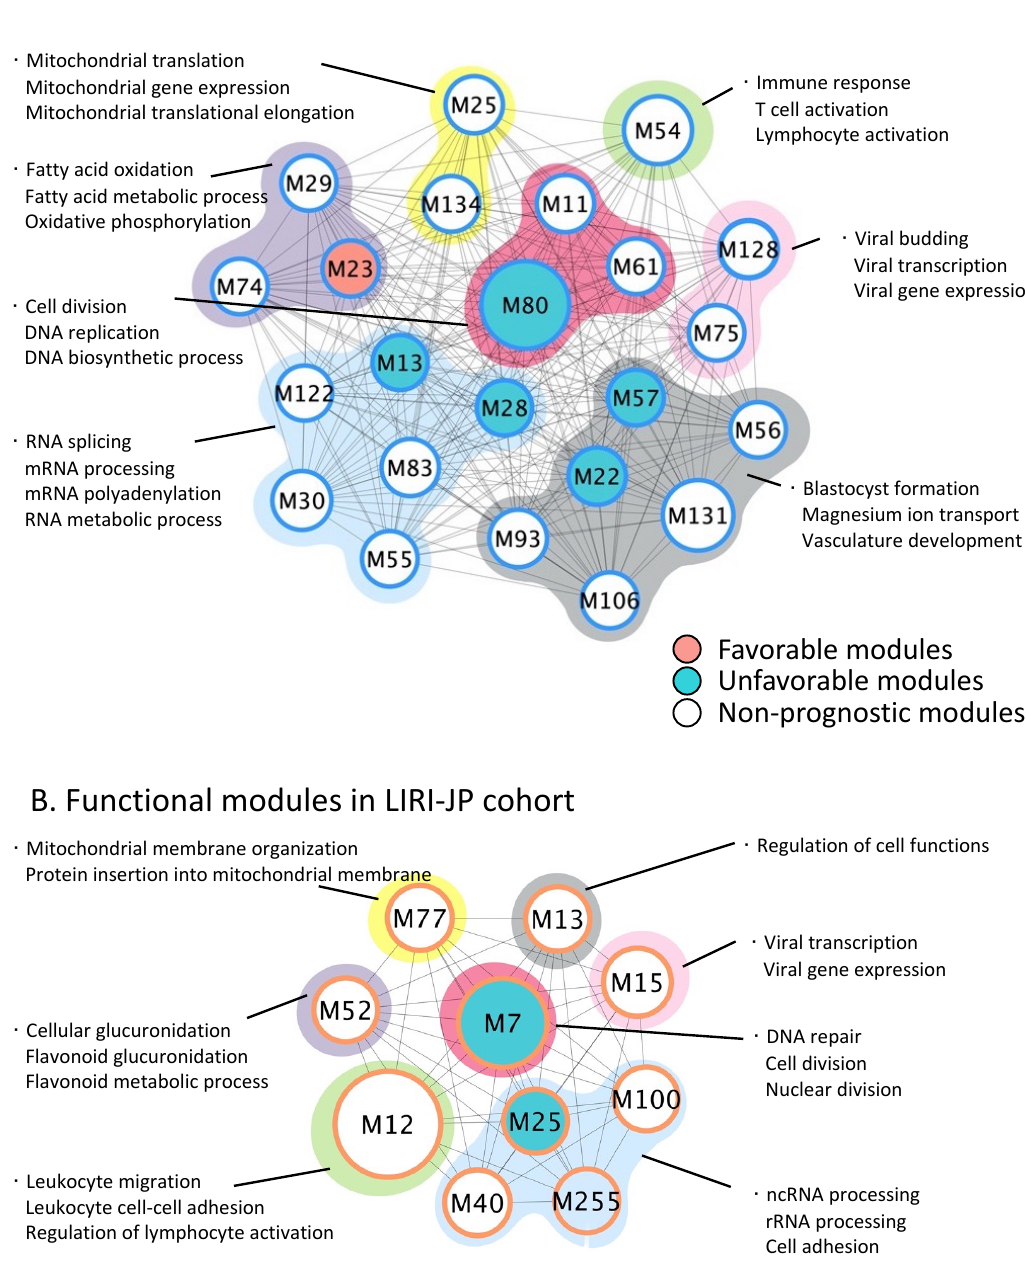
Figure 3. High centrality functional modules in HCC